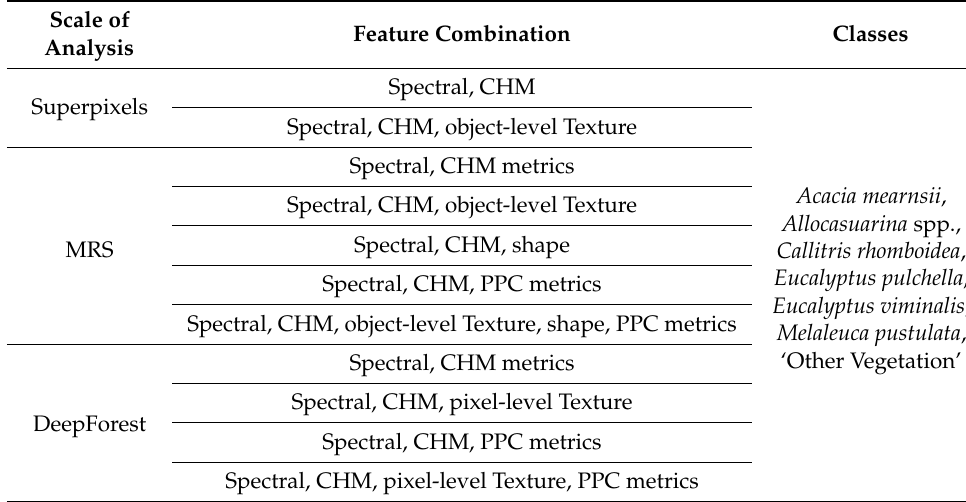
Table 2. Feature combinations used at the three scales of